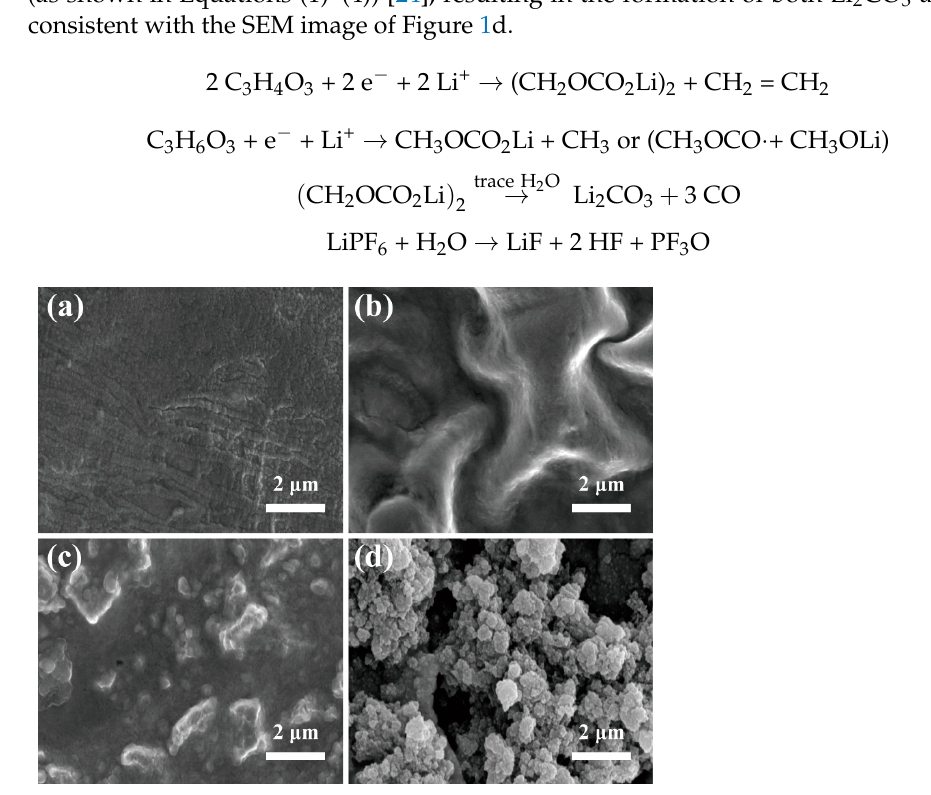
Figure 2. The XPS spectra for Li 1s : ( a ) RT-1D; ( b ) RT-7D; ( c ) 55 °C-7D batteries.